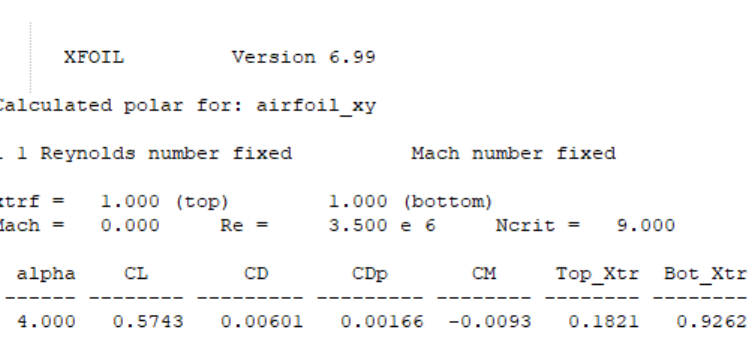
Figure 29. NACA 23012 Xfoil 6.99 polar results — Re 3.5 × 10 6 , alfa 4°. Table 14. NACA 23012 Xfoil 6.99 aerodynamic results segment-wise distribution (Re = 3.5e 6, 𝛼 = 4°).